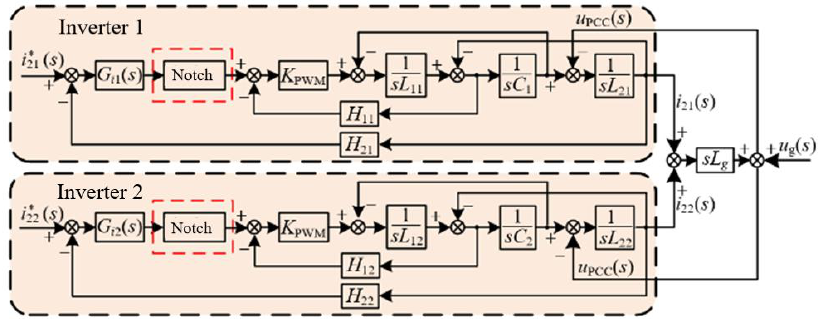
Figure 10. Capacitance current feedback control block diagram based on digital notch.